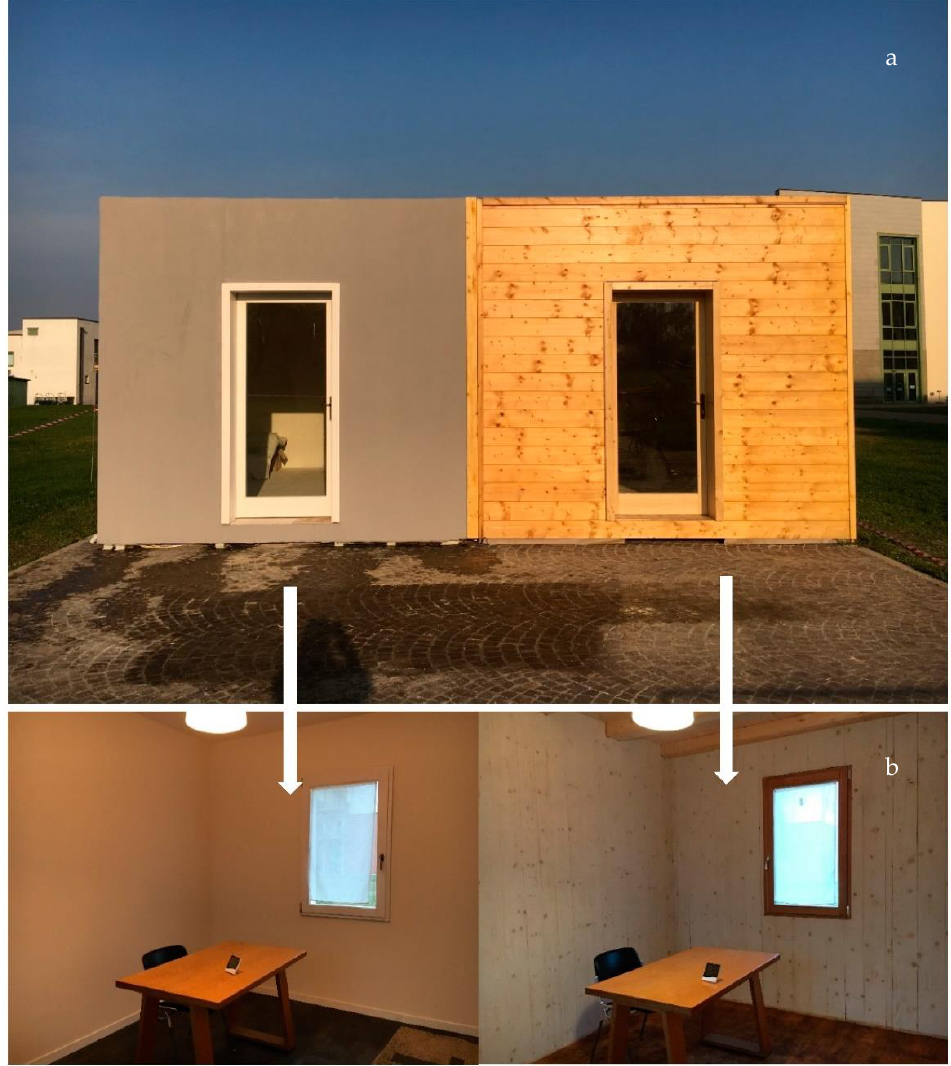
Figure 2. Outdoor ( a ) and indoor ( b ) appearance of the two building environments (left: not-wood; Figure 2. Outdoor (a) and indoor (b) appearance of the two building environments (left: not-wood; right: wood). right: